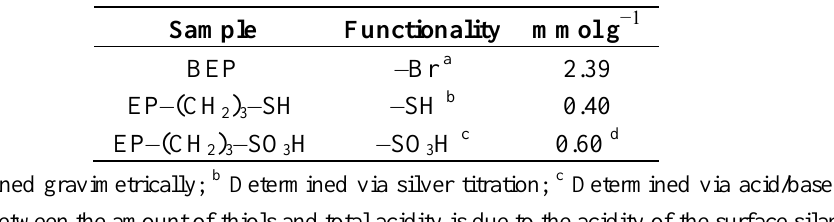
Table 2. Overview of the chemical characteristics of the materials compared in this study.